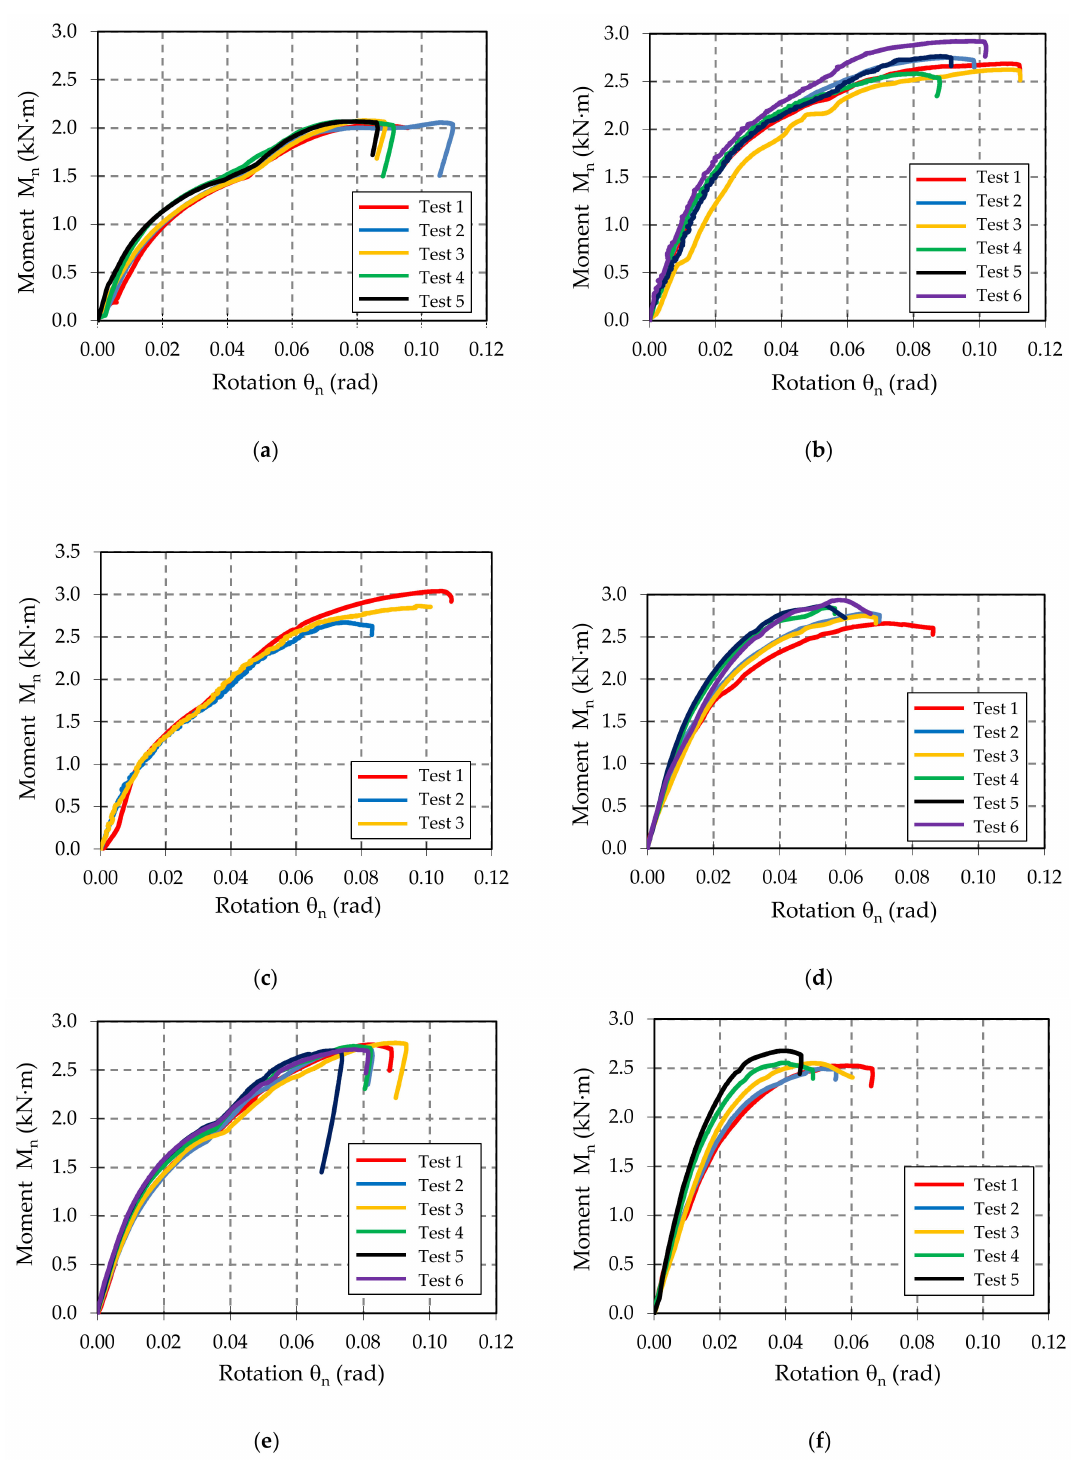
Figure A2. Moment-rotation (M n – θ n ) curves recorded for the beam-connector-upright